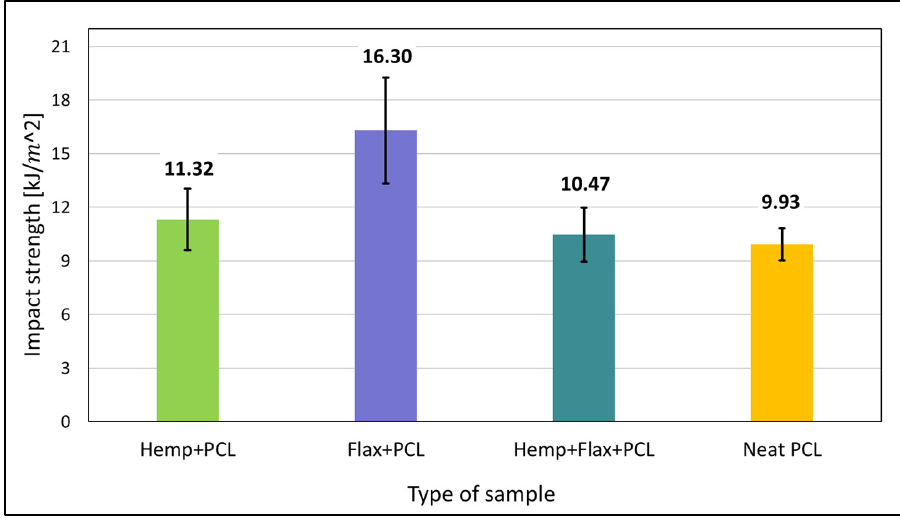
Figure 7. Impact strength comparison of different samples.